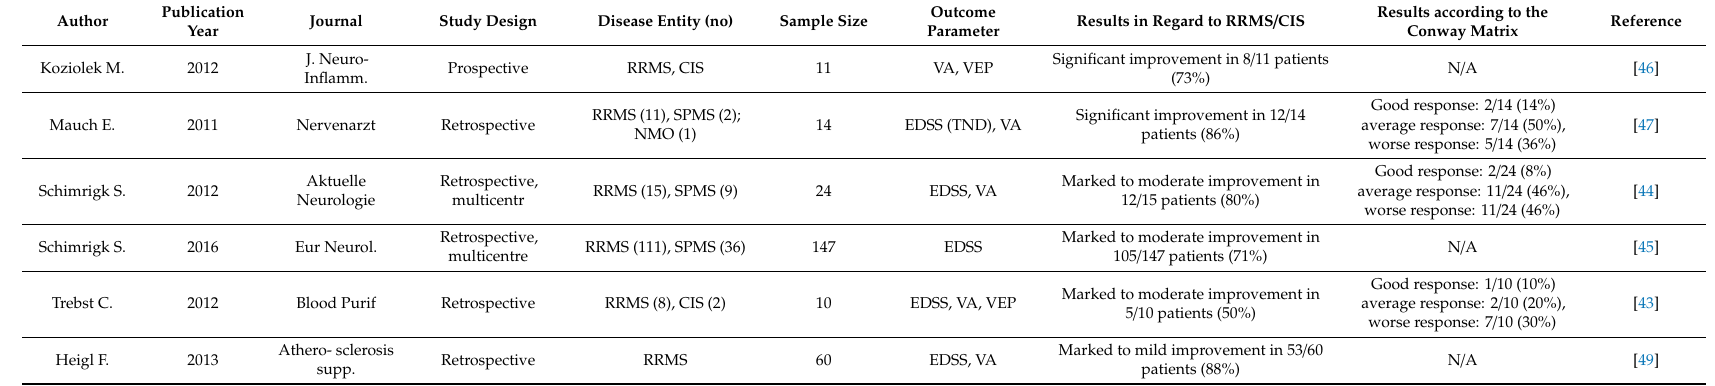
Table 4. Overview of publications on immunoadsorption in acute MS